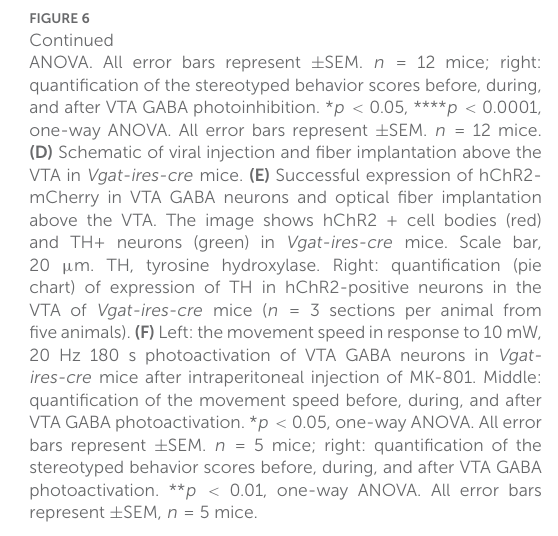
ANOVA. All error bars represent ± SEM. n = 12 mice; right: quantification of the stereotyped behavior scores before, during, and after VTA GABA photoinhibition. * p < 0.05, **** p < 0.0001, one-way ANOVA. All error bars represent ± SEM. n = 12 mice. (D) Schematic of viral injection and fiber implantation above the VTA in Vgat-ires-cre mice. (E) Successful expression of hChR2- mCherry in VTA GABA neurons and optical fiber implantation above the VTA. The image shows hChR2 + cell bodies (red) and TH+ neurons (green) in Vgat-ires-cre mice. Scale bar, 20 µ m. TH, tyrosine hydroxylase. Right: quantification (pie chart) of expression of TH in hChR2-positive neurons in the VTA of Vgat-ires-cre mice ( n = 3 sections per animal from fiveanimals). (F) Left:themovementspeedinresponseto10mW, 20 Hz 180 s photoactivation of VTA GABA neurons in